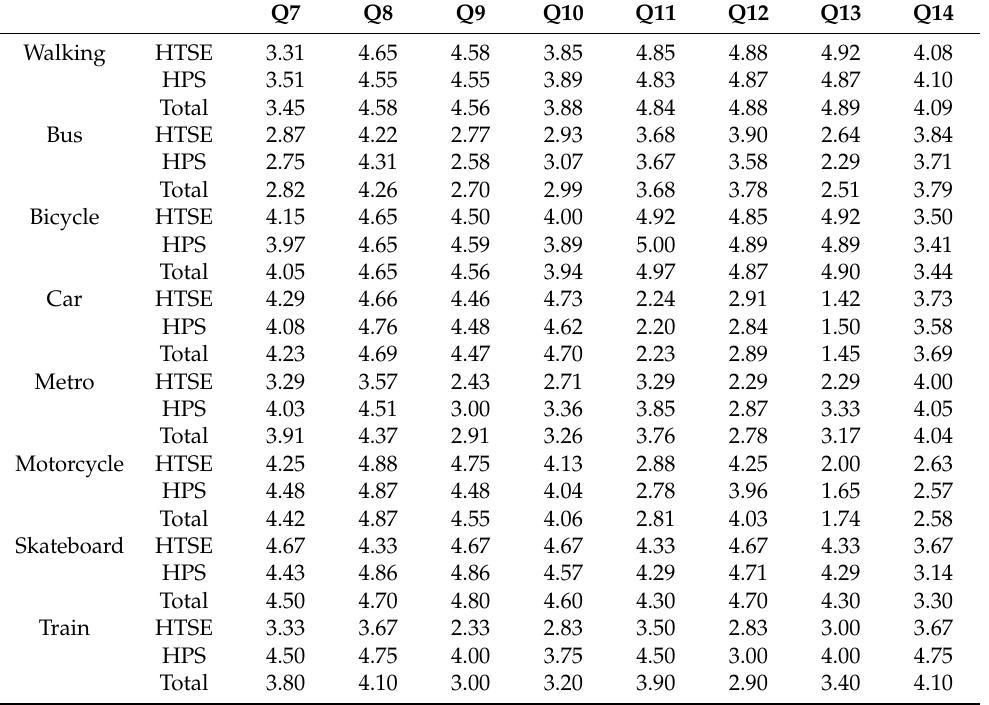
Table 2. Average student responses to items Q7–Q14 (motivation for choice of transportation). Q7 Q8 Q9 Q10 Q11 Q12